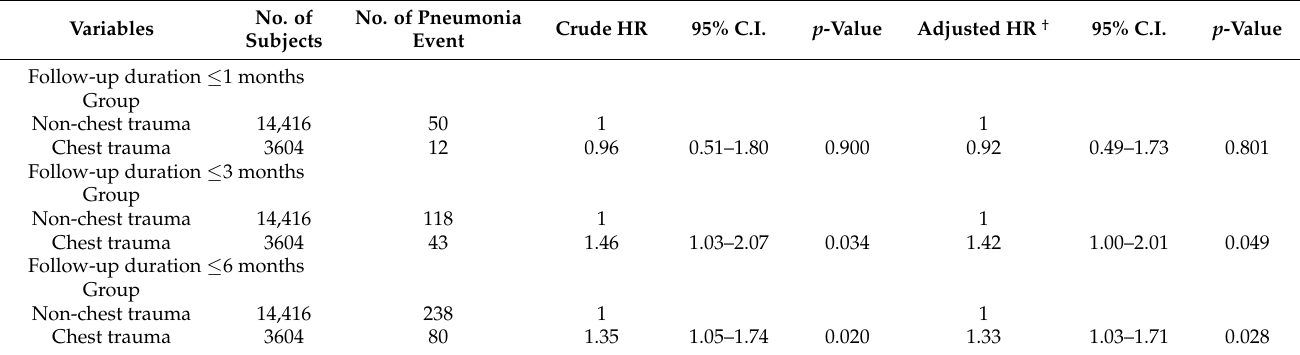
Table 4. Sensitivity analysis for the follow up duration of pneumonia